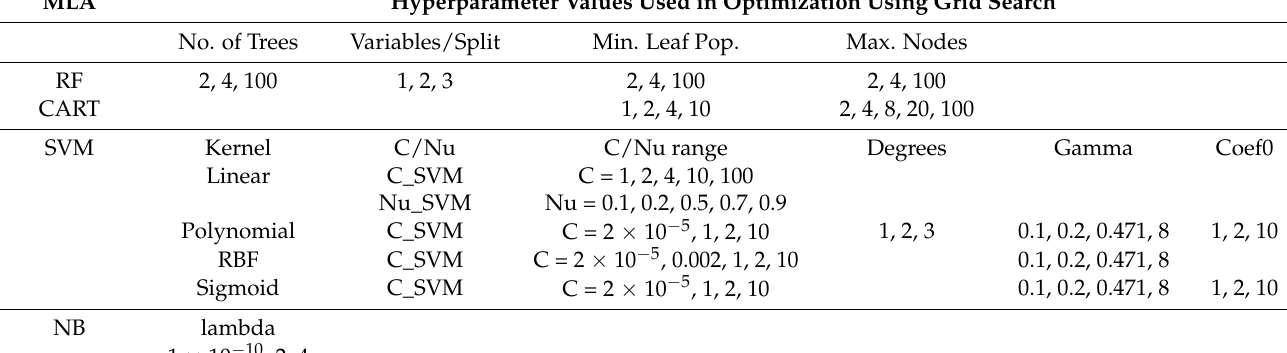
Table 2. Hyperparameters values tried for random forest (RF), CART, naïve Bayes (NB), and support vector machine (SVM) in every possible combination.